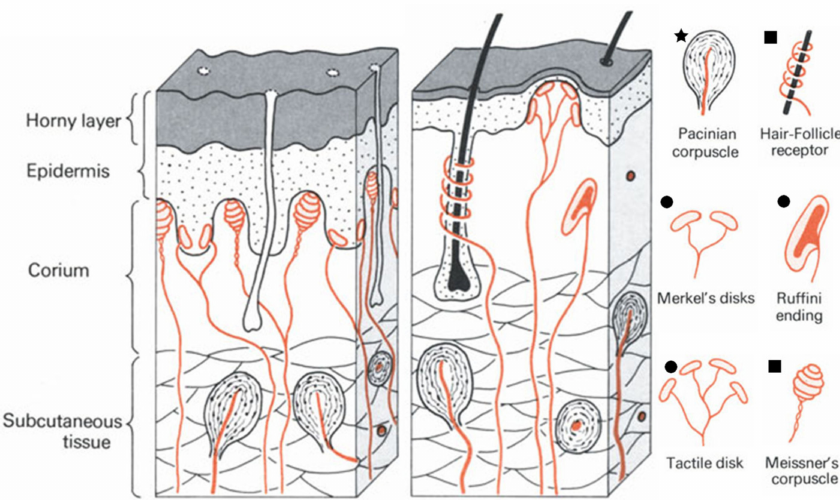
Figure 2. Types of mechanoreceptors present in hairless ( left ) and hairy ( right ) skin (adapted from [2], Copyright © 2020, Springer Verlag). The mechanoreceptors marked with (cid:70) , (cid:4) or • are, respectively, very fast, moderately fast, or slow